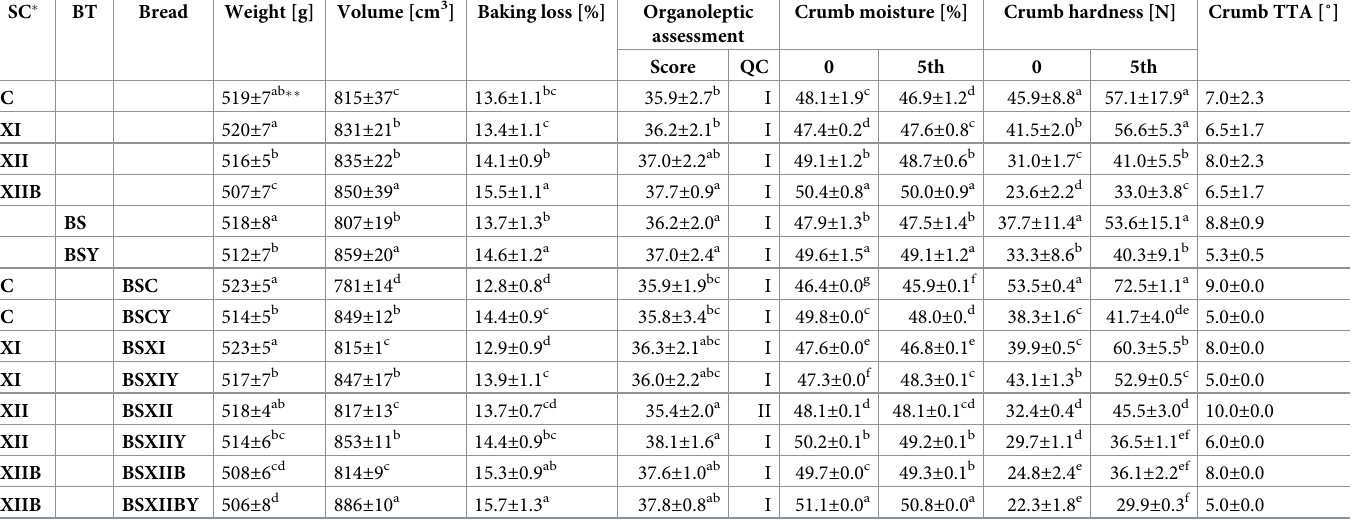
� SC–starter culture, BT–baking technology, QC–quality class, 0 –at day of baking, 5 th –at 5 th day of storage, TTA–total titratable acidity expressed in terms Acidity degree. �� Average ± SD; values within the column section denoted with the same superscript are not statistically different according to Duncan test ( α � 0.05).